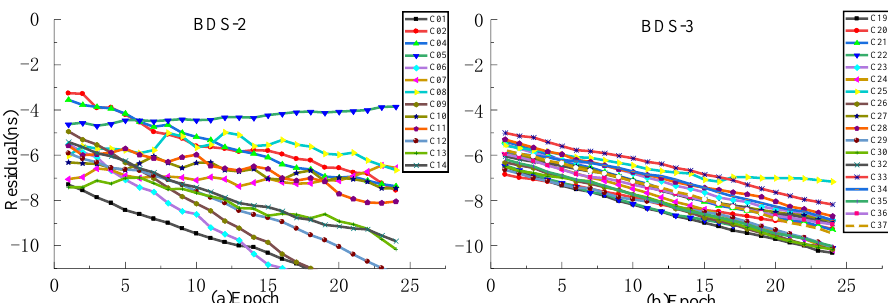
Figure 9. The residual plot of the ISUP model using the initial hour update ultra-fast clock product of the next day. ( a ) The residual value of BDS-2 predicted after 6 h. ( b ) The residual value of BDS-3 predicted after 6 h.